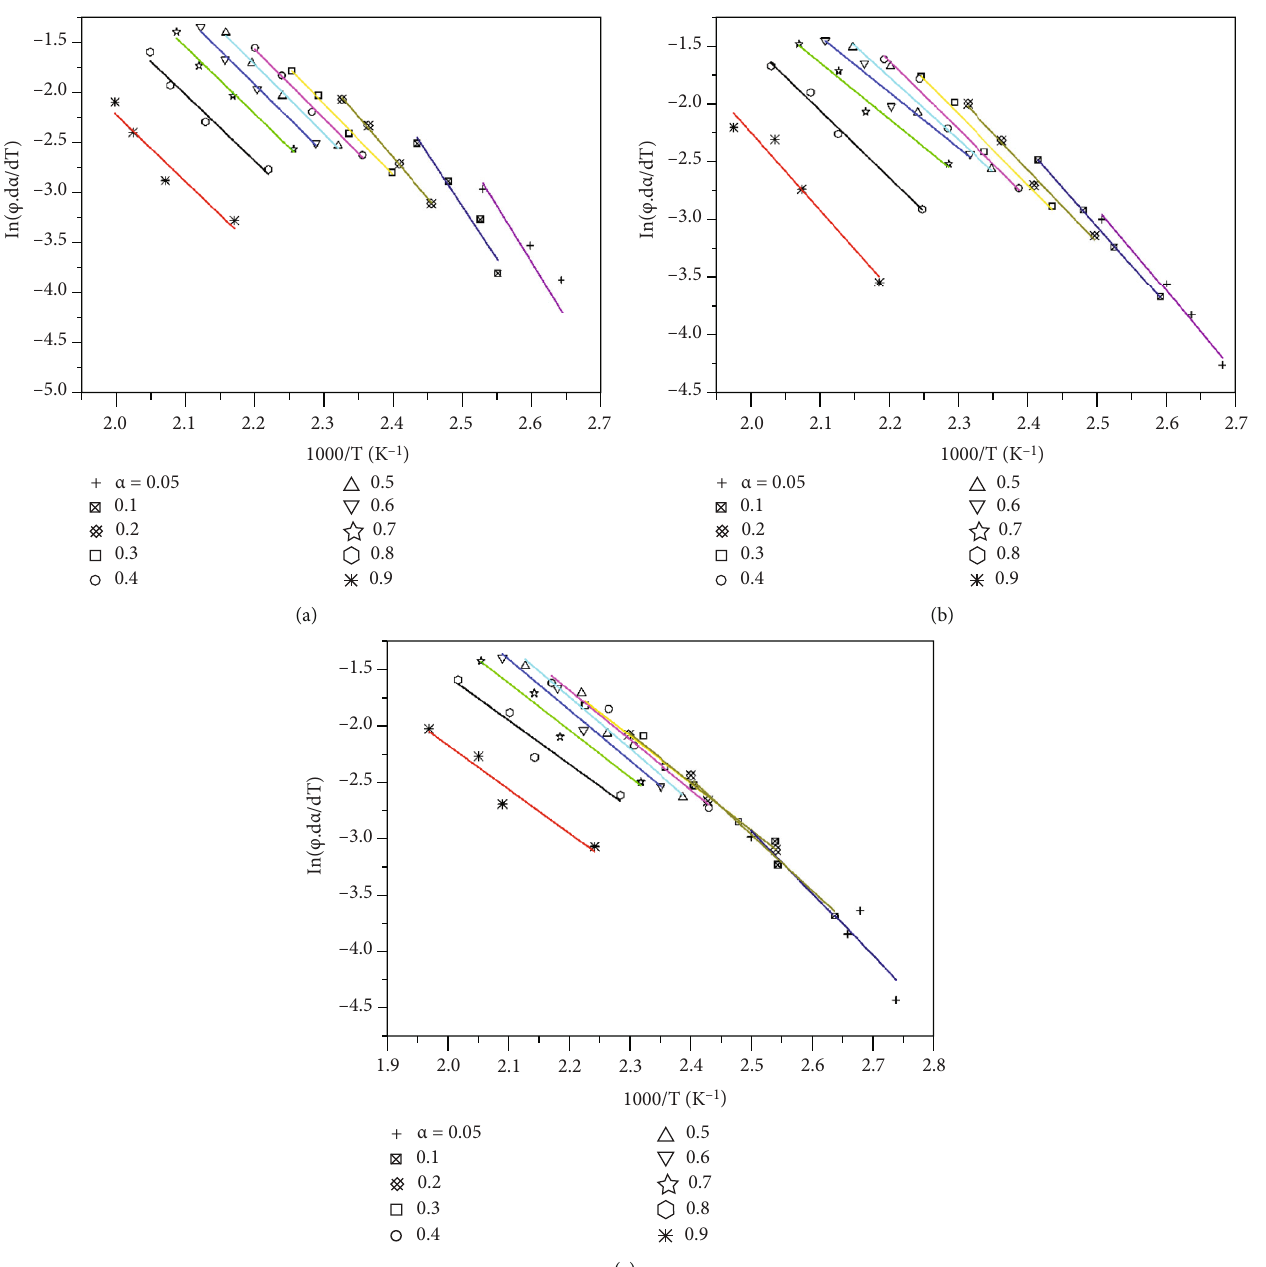
Figure 6: Typical plots of ln(d α /dt) vs. 1/ T for (a) GEP, (b) GELP, and (c) GELNiP nanocomposites based on Friedman model at φ = 5 ° C/min